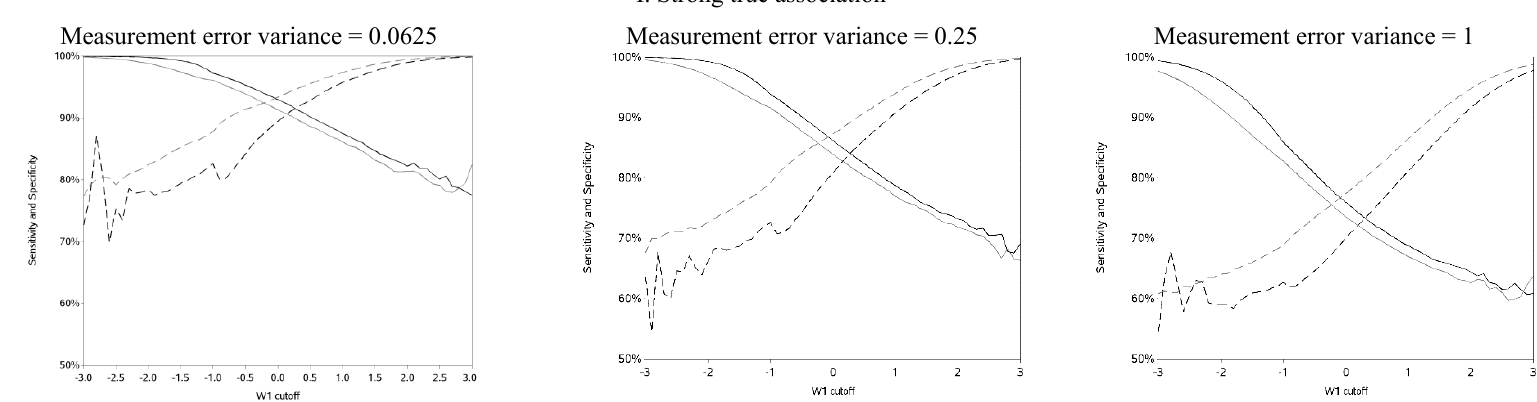
Figure A4. Sensitivity and specificity at each cutoff for W 1 (all scenarios for Figure 4). Cases—black; Controls—grey; Sensitivity—solid lines; Specificity—dotted